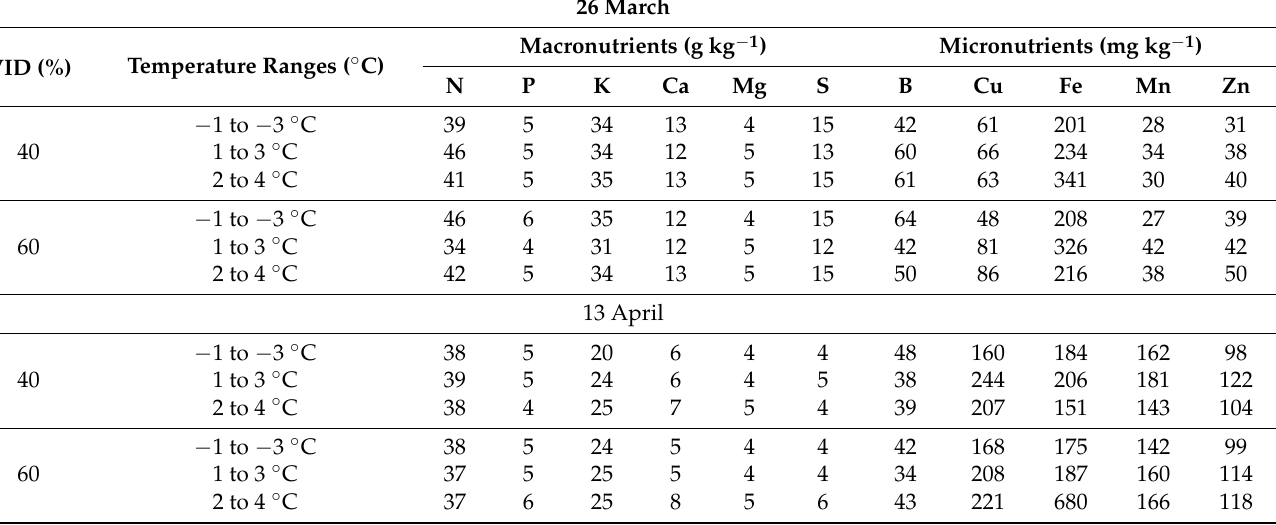
Table 3. Levels of foliar nutrients in garlic plants, under different temperatures ranges and visual index of overcoming dormancy